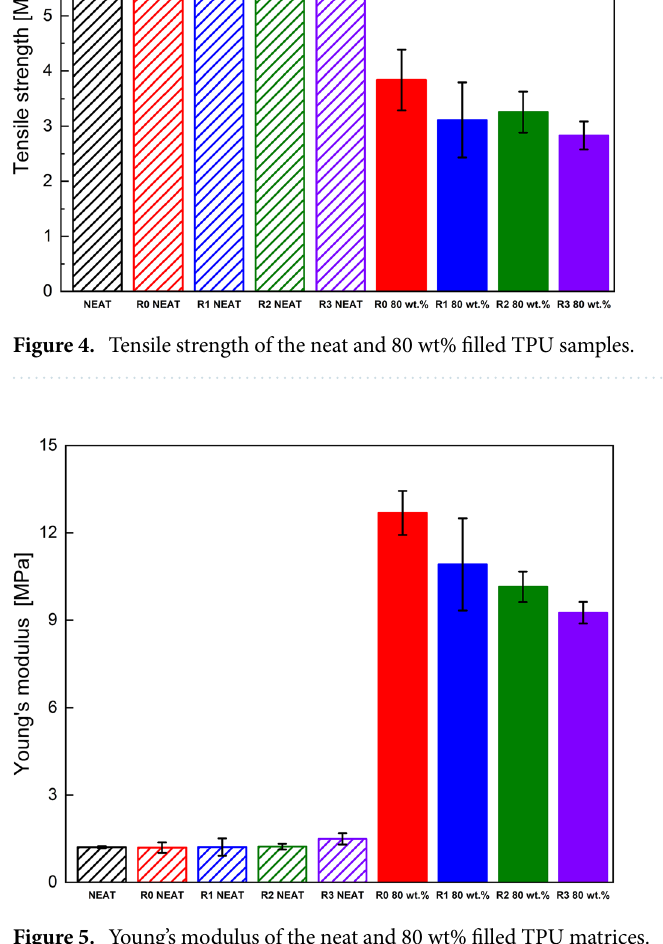
Figure 5. Young’s modulus of the neat and 80 wt% filled TPU